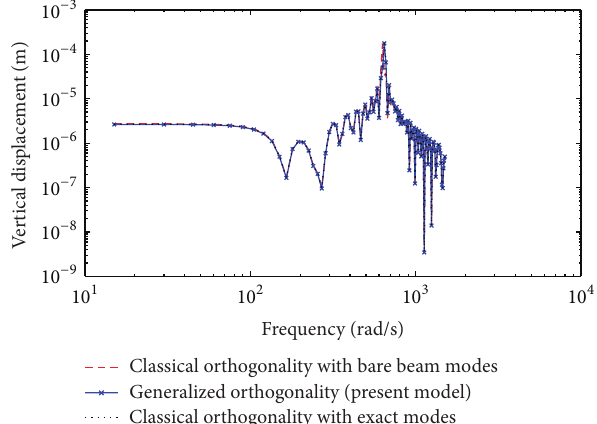
Figure 7: Frequency response of a guided-guided beam carrying one in-span mass-spring-damper-mass system for 𝑘 = 10 N/m, = 0.1 kg, 𝑀 = 0.05 kg, 𝑇 = 360 N, 𝐸𝐼 = 36.458 Nm 2 , 𝑀 𝑑 𝑐 = 0.1 Ns/m, and 𝐿 = 0.1 m. 𝑐 𝑑 𝑑